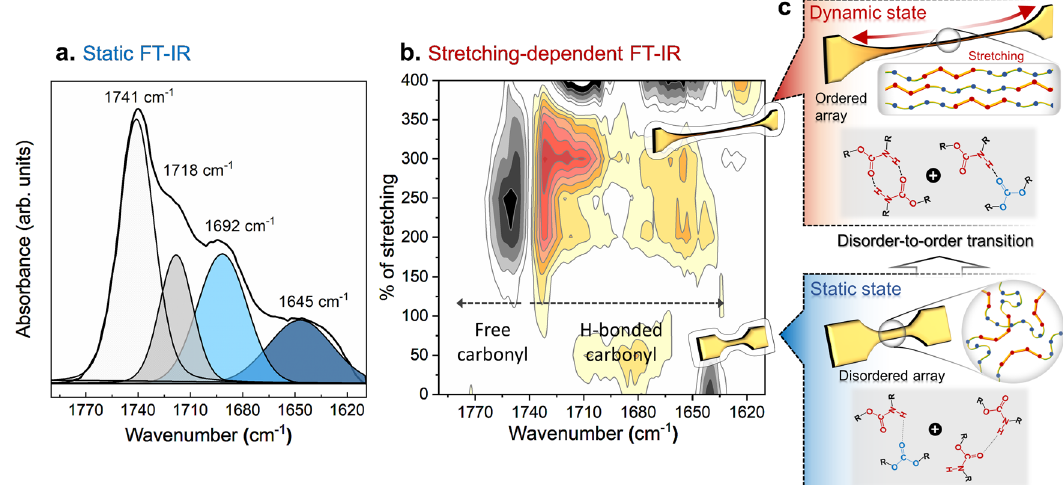
Fig. 4 FT-IR analysis of C-IP-SS in the static and dynamic states. a The carbonyl region of the FT-IR spectrum of C-IP-SS with peak deconvolution. b 2D gradient FT-IR map with respect to stretching percentage. The red contour lines represent positive values of d A /d E (the fi rst derivative of the absorbance ( A ) as a function of the extension % ( E )); i.e., an increasing trend in absorbance as a function of the degree of extension, and vice versa, for the gray contour lines. c Schematic of the mechano-responsive changes in chain alignment and the associated H-bond arrays for